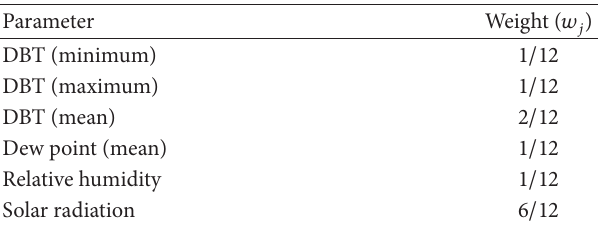
Table 1: Weighting factors of FS